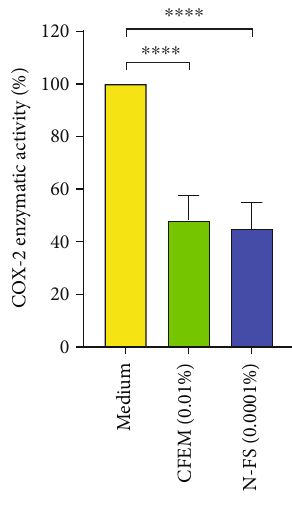
Figure 10: 5-LOX enzymatic inhibition: endogenous 5-LOX enzymatic activity in THP-1 cells di ff erentiated in macrophages (PMA). Macrophages pretreated with CFEM or N-FS (N- feruloylserotonin) for 1 hour. 5-LOX induction (IL-3) with the test substance for 24 hours. One-way ANOVA: ∗∗∗ p < 0 : 005 ; ∗∗∗∗ p < 0 : 0001